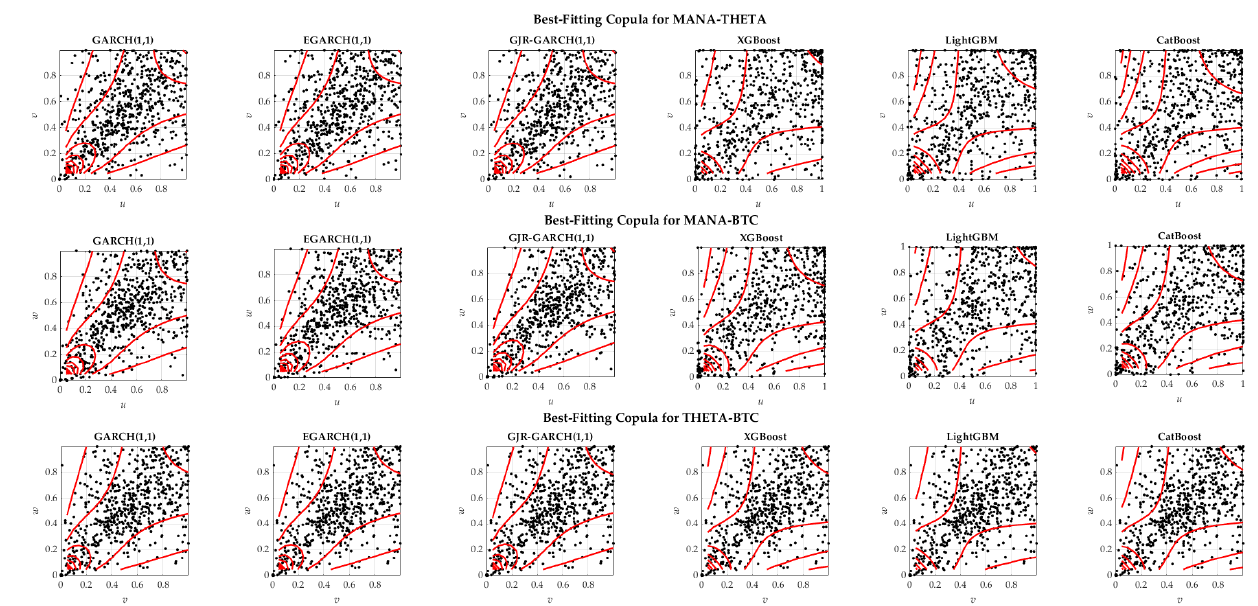
Figure 5. Best-fitting copulas.